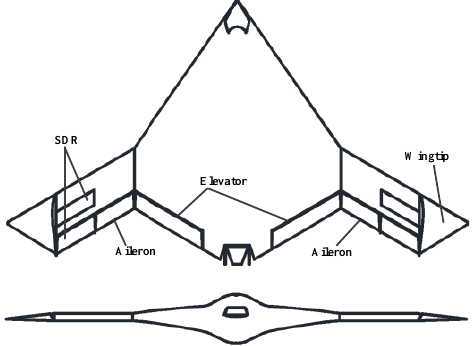
Figure 1. Layout of the tailless